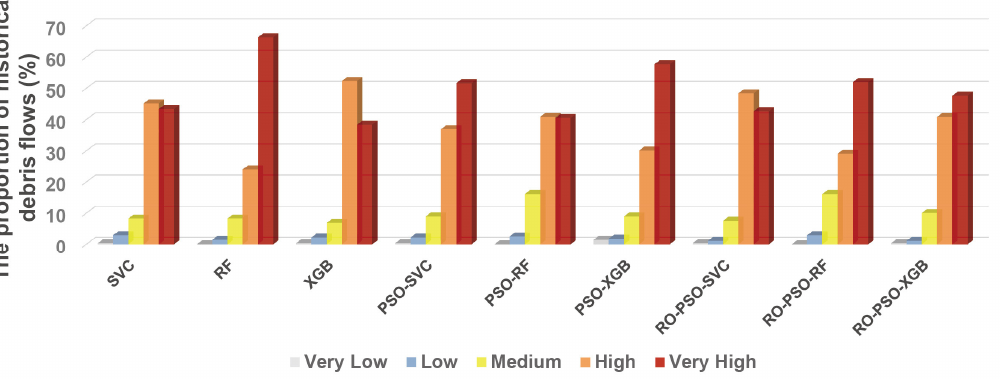
Figure 12. Proportions of the historical debris flow occurring at the catchments with different susceptibility levels among the different models.